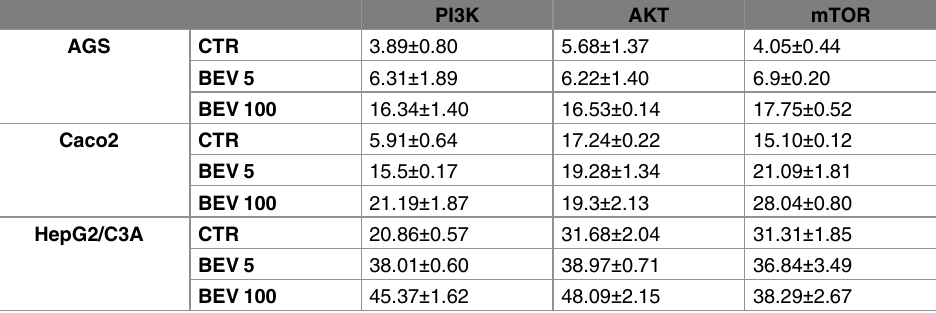
Table 1. The effect of bevacizumab treatment on PI3K, AKT, and mTOR